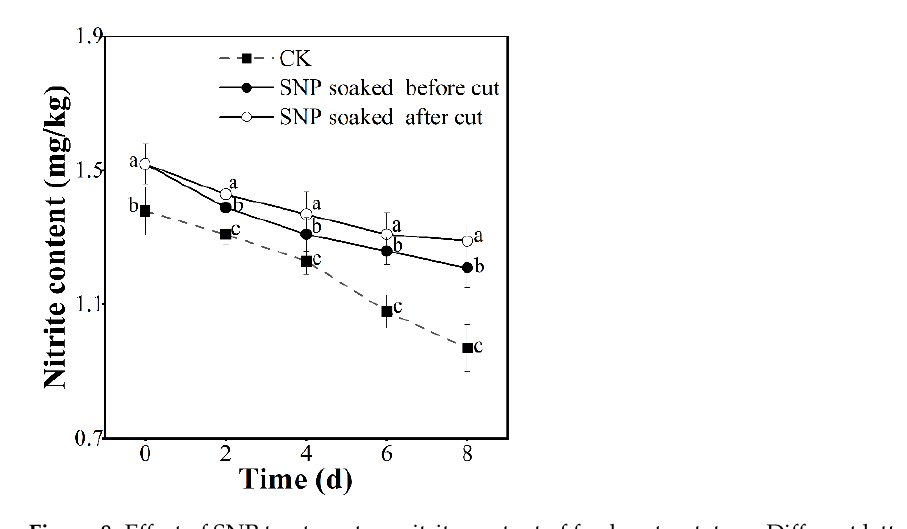
11 of 14 Figure 7. Effect of SNP treatment on NO content of fresh-cut potatoes. Different letters indicate significant differences among treatments at same storage time ( p < 0.05). 3.8. Effect of Treatment with SNP on Potato Edible Safety In this study, the nitrite content was used to evaluate the edible safety of fresh-cut potatoes treated with SNP. With the extension of storage time, the nitrite content in the fresh-cut potatoes treated with SNP before being cut was significantly lower than that in the potatoes treated with SNP after being cut (Figure 8). Additionally, the nitrite content in the untreated group was significantly lower than that in the remaining groups ( p < 0.05),